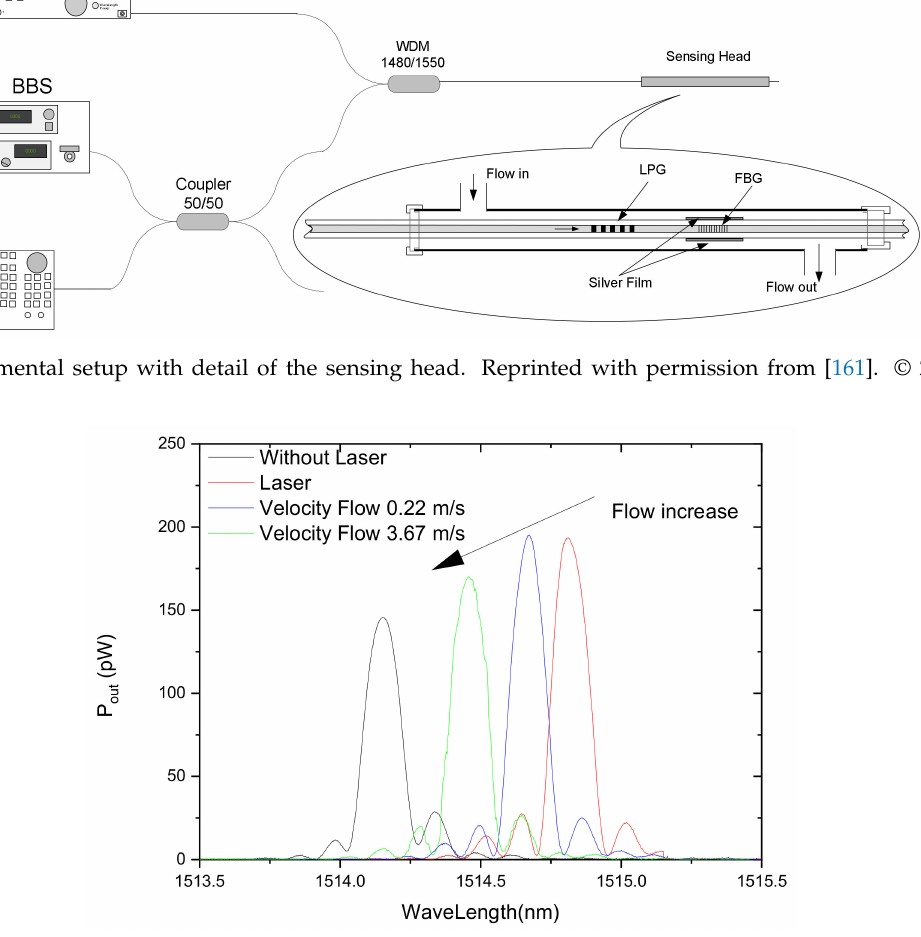
Figure 24. Response of the FBG Bragg wavelength as a function of air flow (laser on). Adapted with permission from [161]. © 2021 The Optical